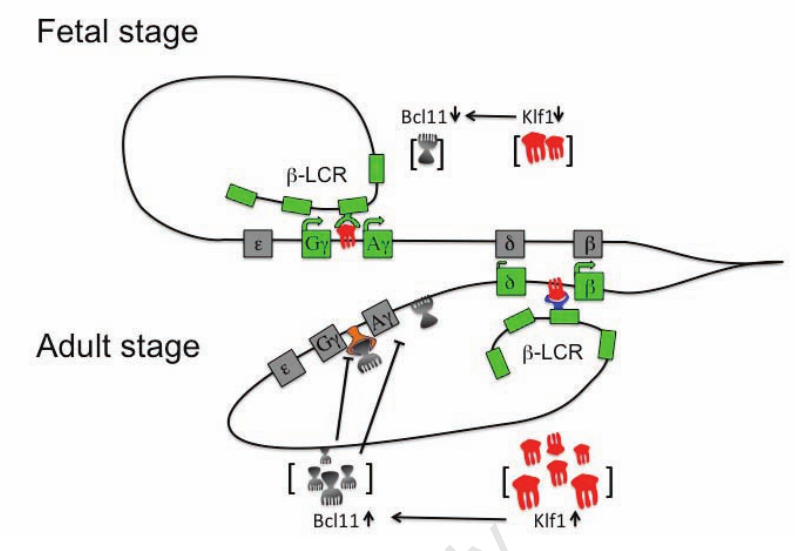
Figure 5. Current hemoglobin switching model. Globin gene activation is dependent upon concentration of Klf1. In the fetal stage of erythroid development or at low Klf1 concentration, weakly expressed Bcl11A can not repress γ -globin genes and Klf1 prefer- entially interacts with the γ -globin genes that are stimulated upon recruitment of LCR elements. In the adult stage or at high Klf1 concentration, overexpressed Bcl11A repress- es γ -globin genes and Klf1 binds preferentially the β -globin genes that are stimulated upon recruitment of the LCR (Inactive genes are grayed, active genes are in light green). LCR, Locus control region; KLF, Krueppel-like factor; Bcl11A: B cell lymphoma